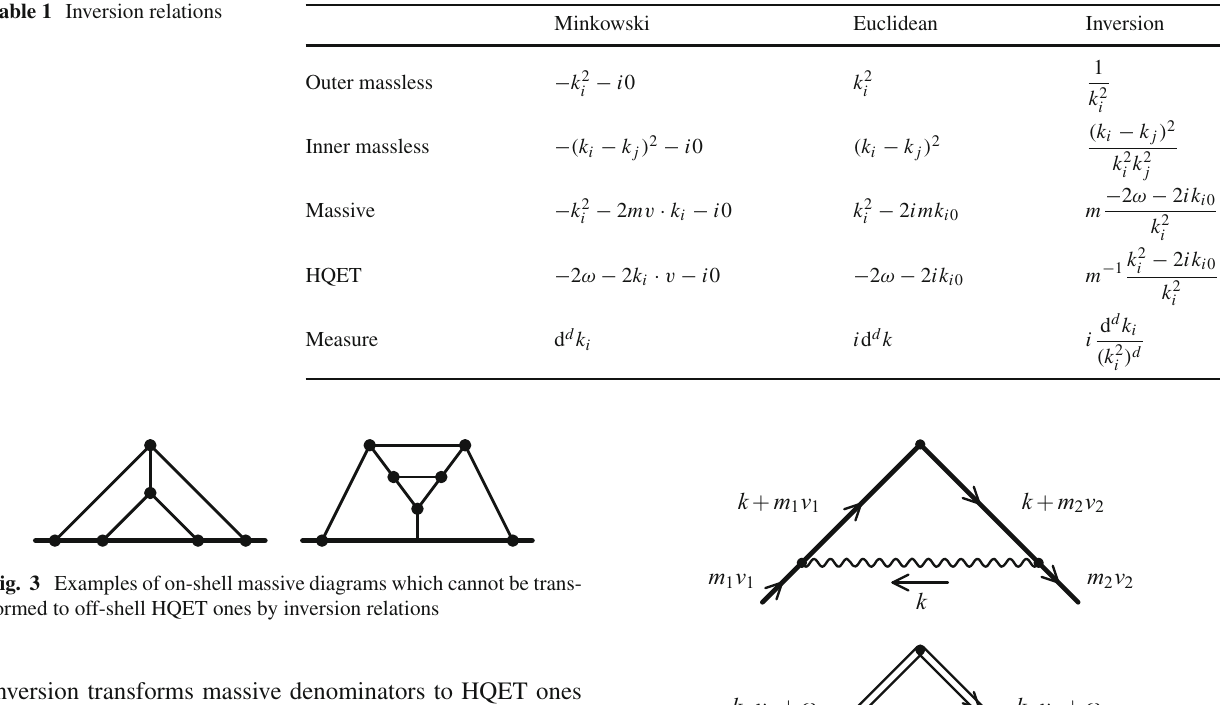
Inversion transforms massive denominators to HQET ones